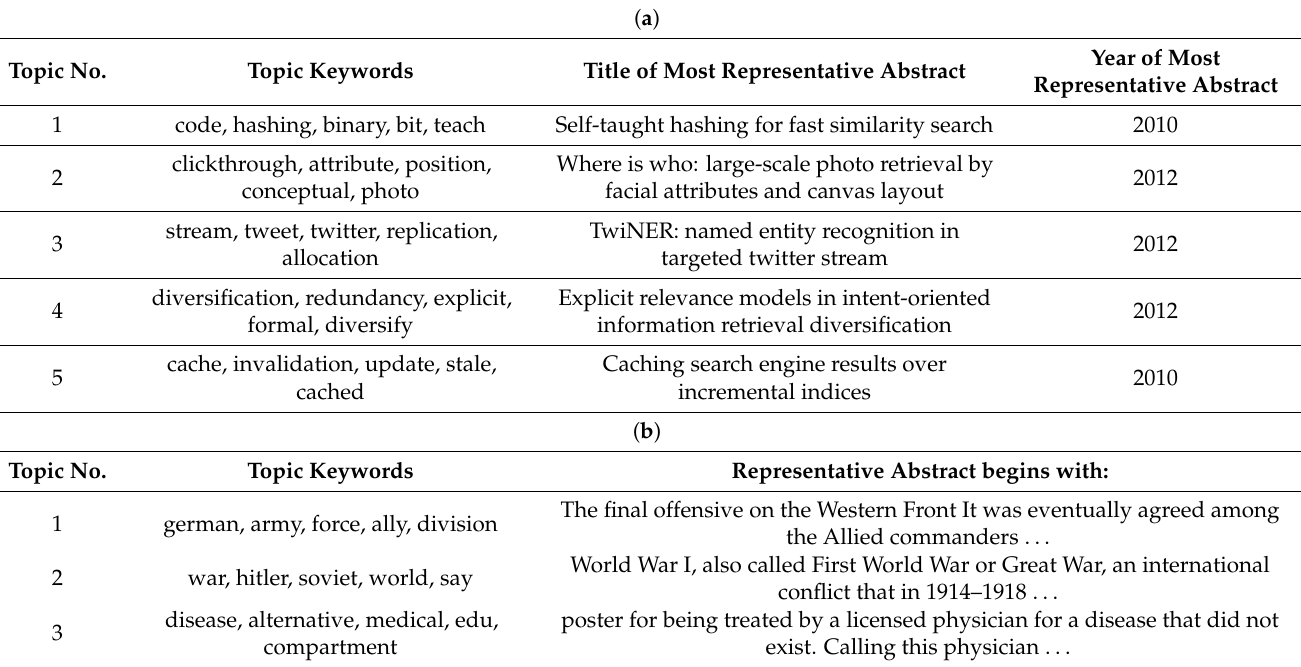
Table 10. Framework #2 emerging topics for (a) SIGIR and (b) 10 Newsgroups